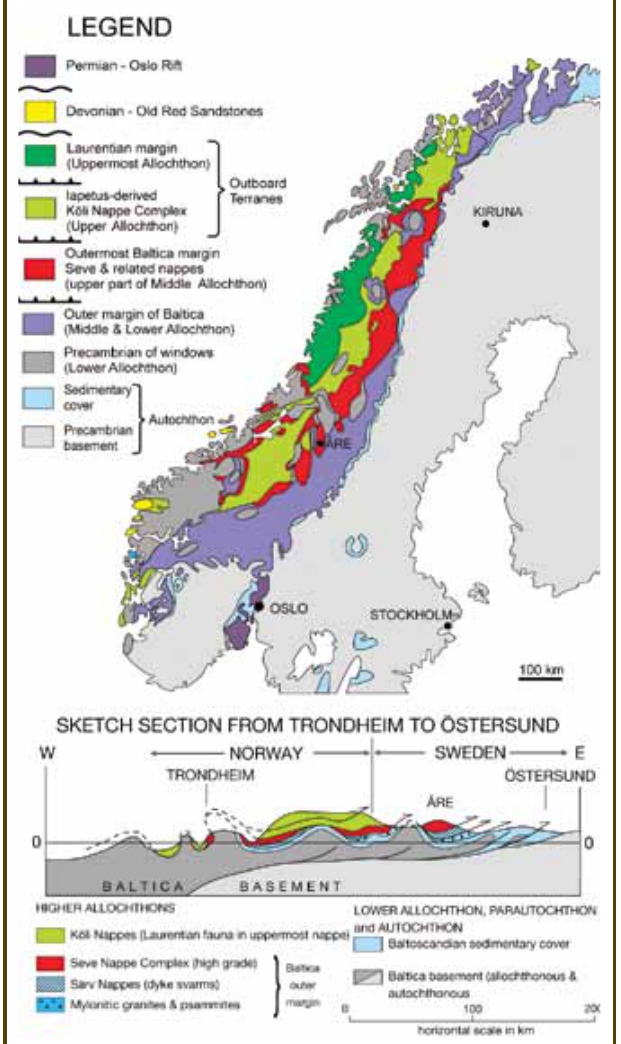
Figure 1. Tectonostratigraphic map of the Scandinavian Caledonides and sketch section along the geotraverse from Östersund to the Norwegian coast (modified from Gee et al.